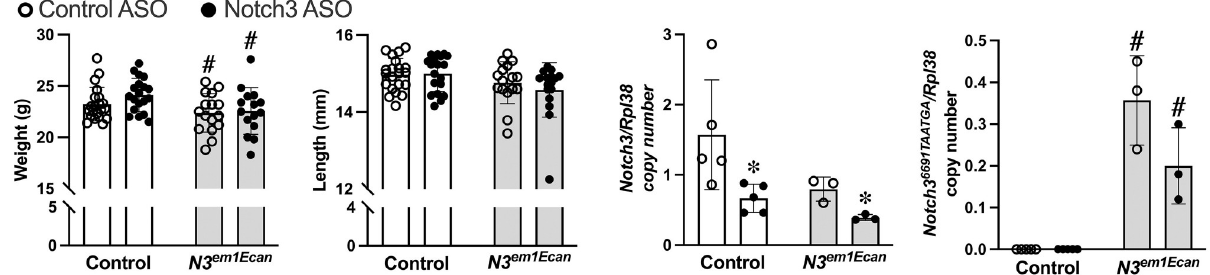
Fig 4. Body weight, femoral length and Notch3 transcripts of 8.5–9 week old male Notch3 em1Ecan mutant mice (gray bars) and littermate controls (white bars) treated with Notch3 ASO (closed circles) or control ASO (open circles) at 50 mg/kg subcutaneously, once a week for 4 weeks. Individual values are shown, and bars and ranges represent means ± SD; n = 16 to 21 biological replicates, except for mRNA values n = 4 biological replicates. � Significantly different between Notch3 ASO and control, p < 0.05. #Significantly different between Notch3 em1Ecan mutant and control mice, p <